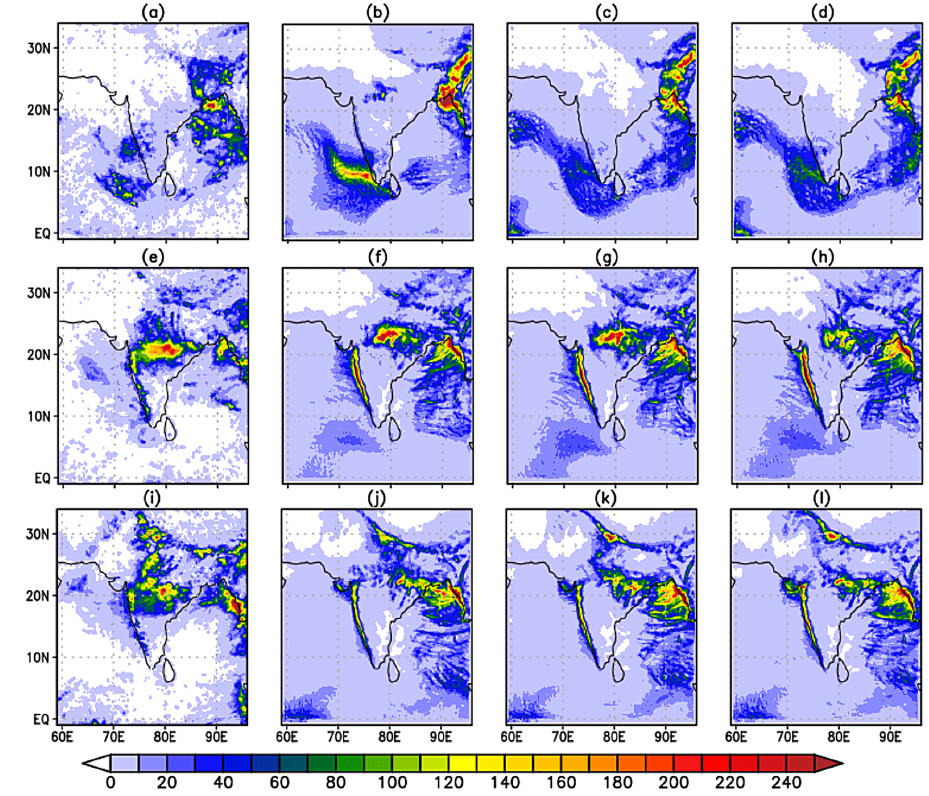
Figure 7. 48h accumulated precipitation for case 1 (a–d) , case 2 (e–h) and case 3 (i–l) depressions from TRMM (a, e, i) , CTRL run (b, f, j) , cv5 run (c, g, k) and cv6 run (d, h, l)